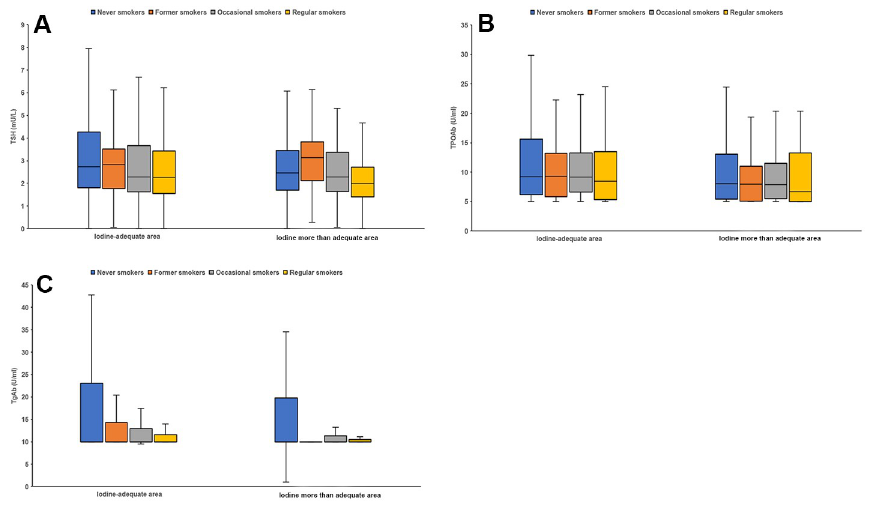
Fig 1. Box plot of TSH (A), TPOAb (B) and TgAb (C) levels among different smoking status groups between iodine-adequate area and iodine more than adequate area. The data were expressed as minimum, P 25 , median, P 75 , maximum.